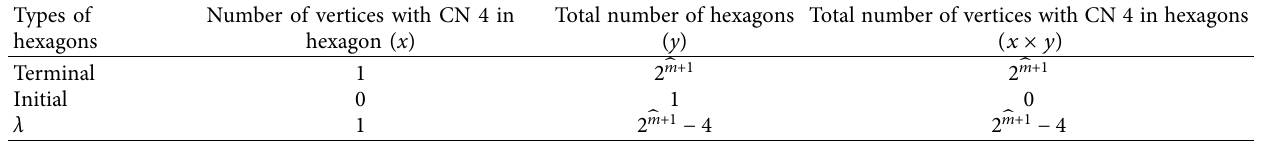
Table 2: Total number of vertices with CN 4 in ζ .